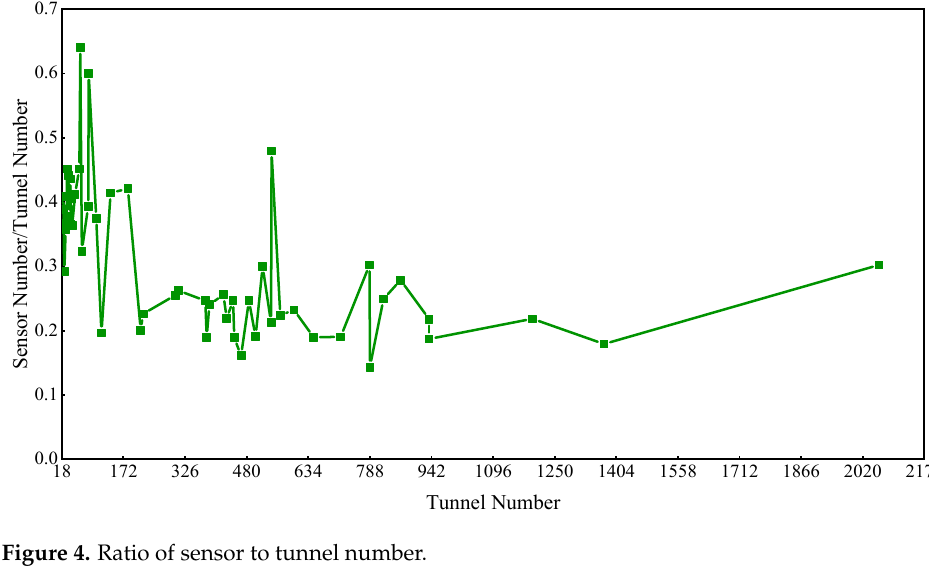
Figure 4. Ratio of sensor to tunnel number.